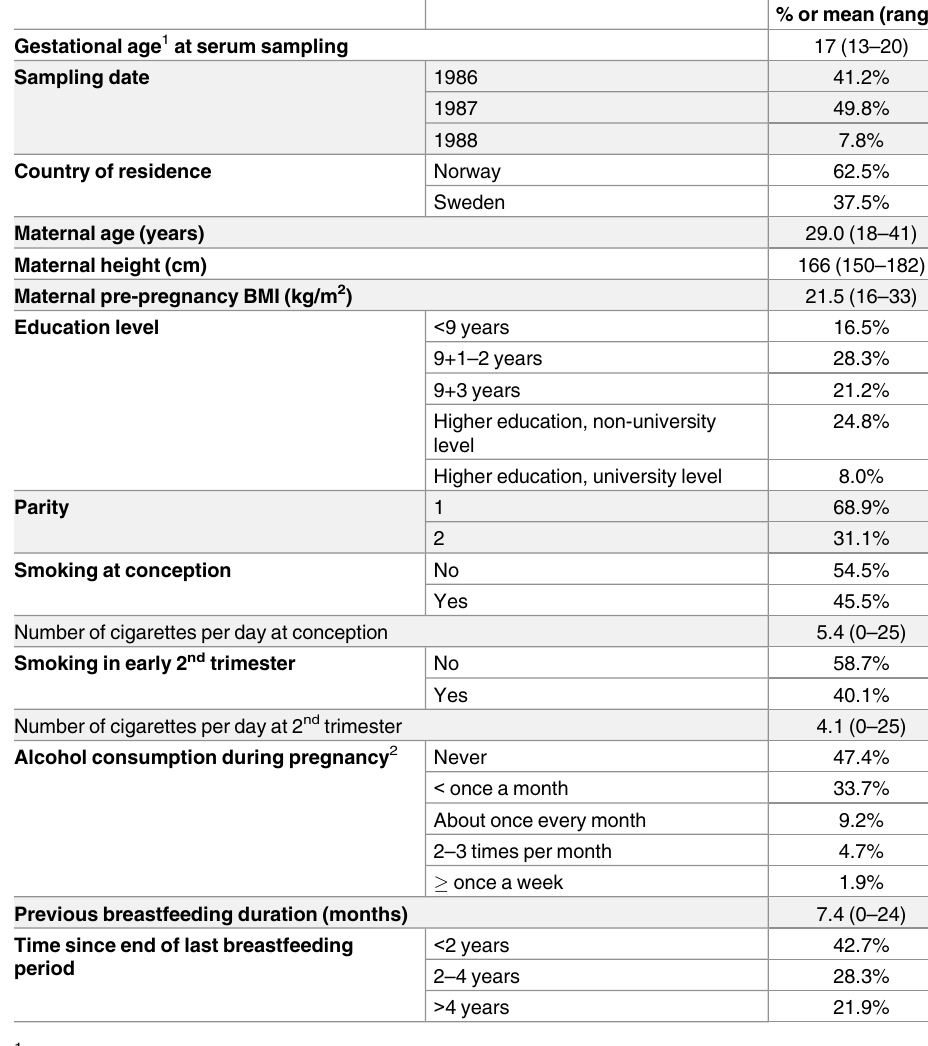
Table 1. Maternal characteristics of the current sample of Scandinavian parous pregnant women in the SGA-study (N =